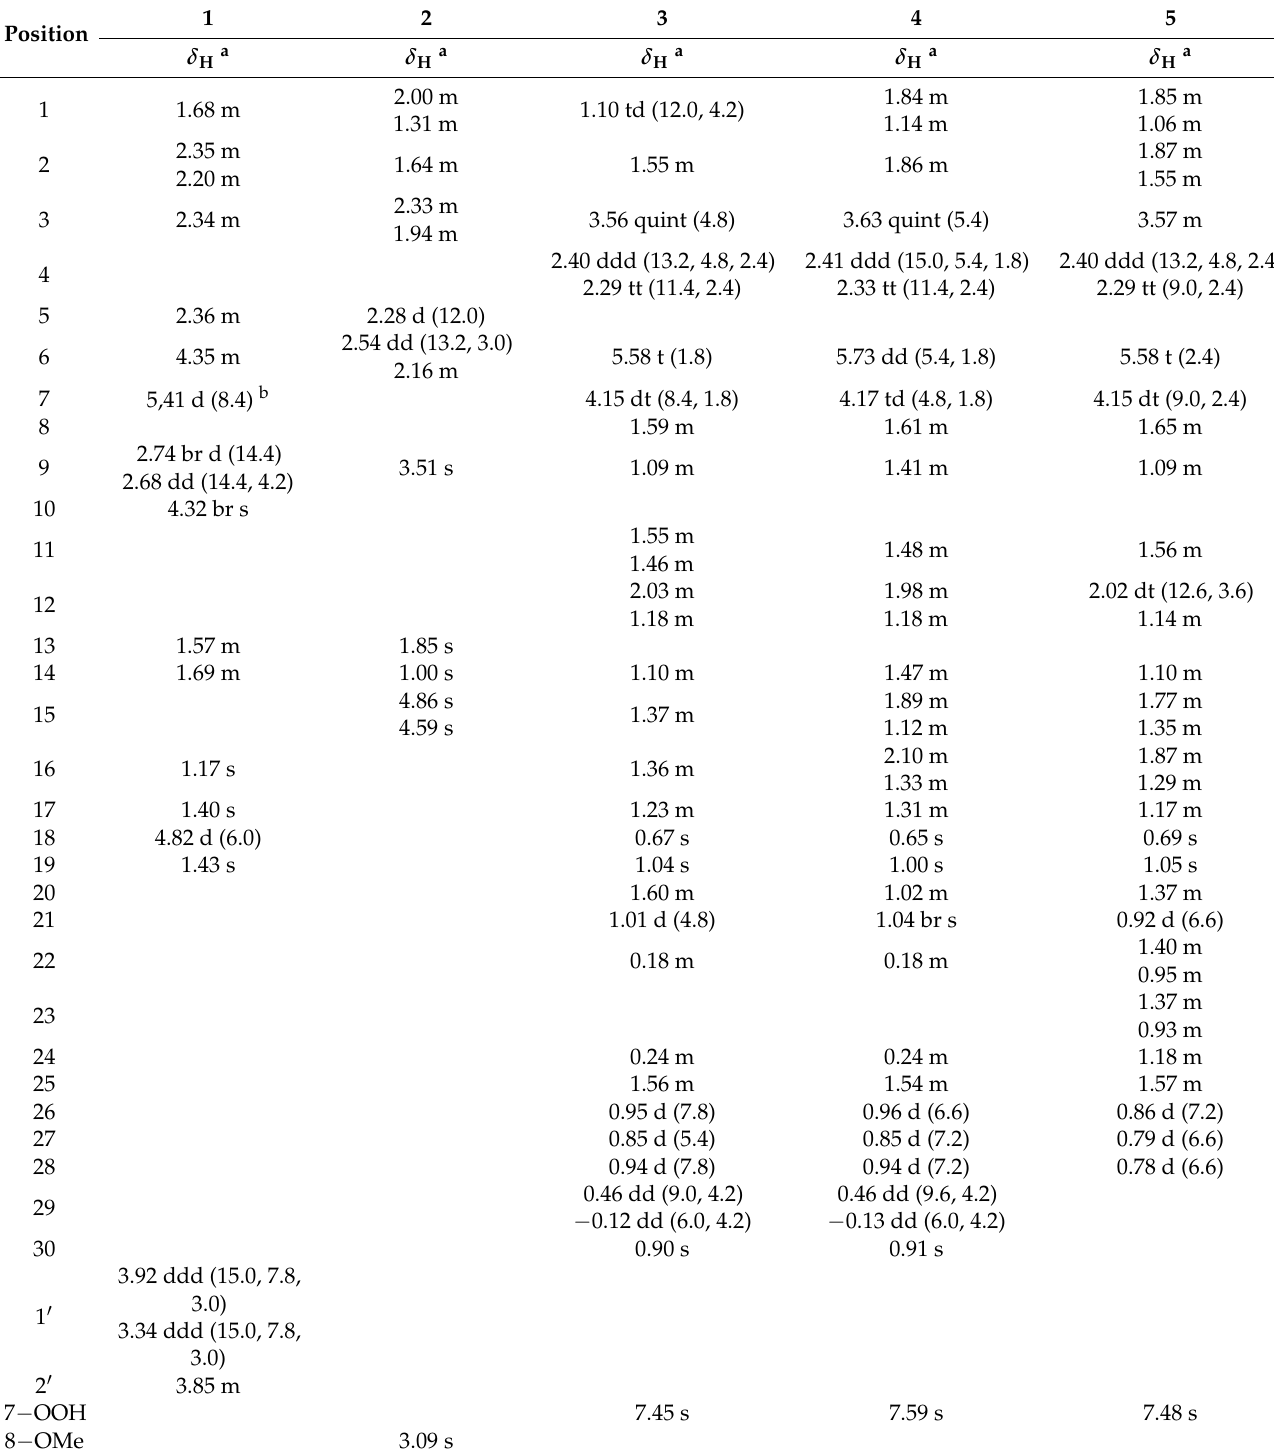
Table 1. 1 H NMR spectroscopic data of compounds 1 – 5